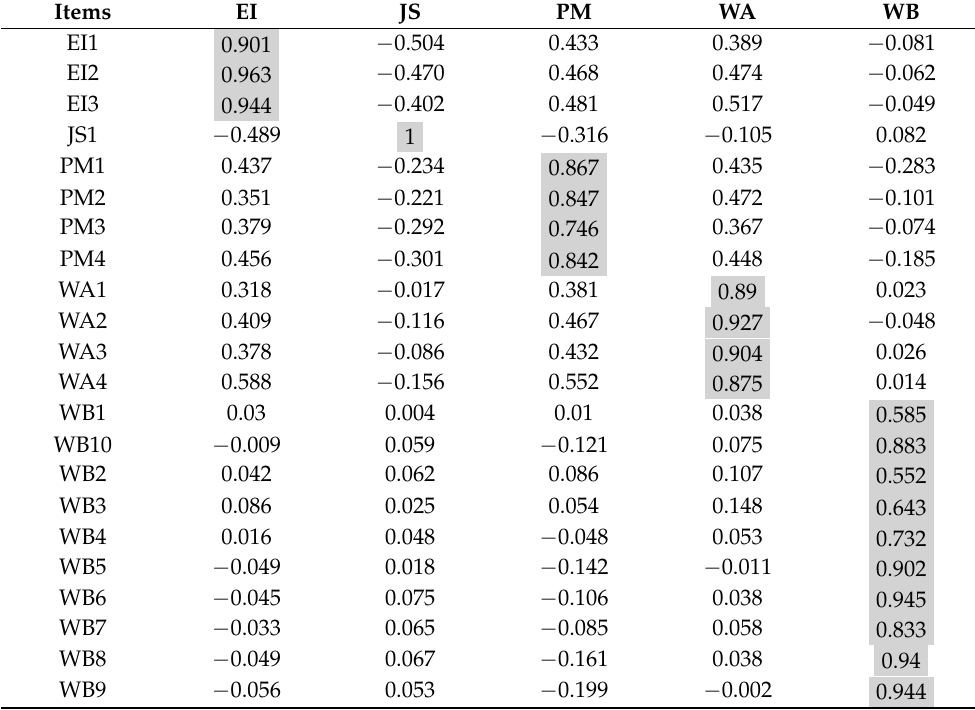
Table 4. Standardized factor loadings and cross-loadings of the outer